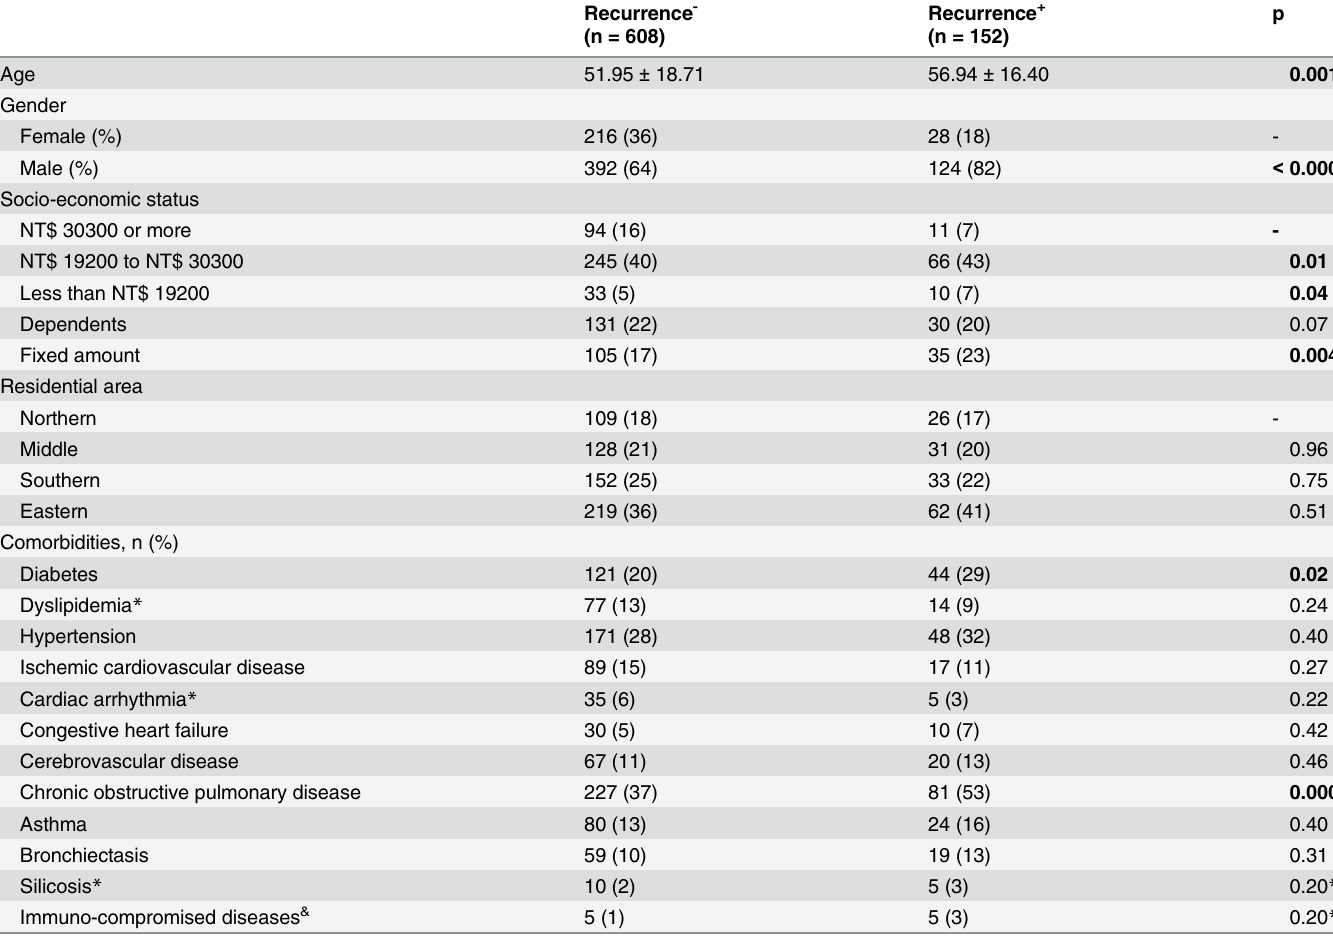
Table 1. Characteristics of control and case